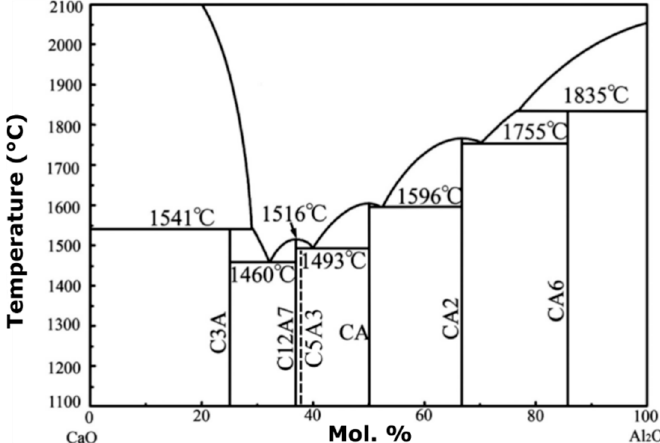
Figure 1. Calculated CaO–Al 2 O 3 phase diagram under ambient “humid” synthesis conditions, modified from Liao et al. [1]. The metastable C5A3 position is represented by the dotted line; however, C5A3 is only observed to form under non-humid conditions.